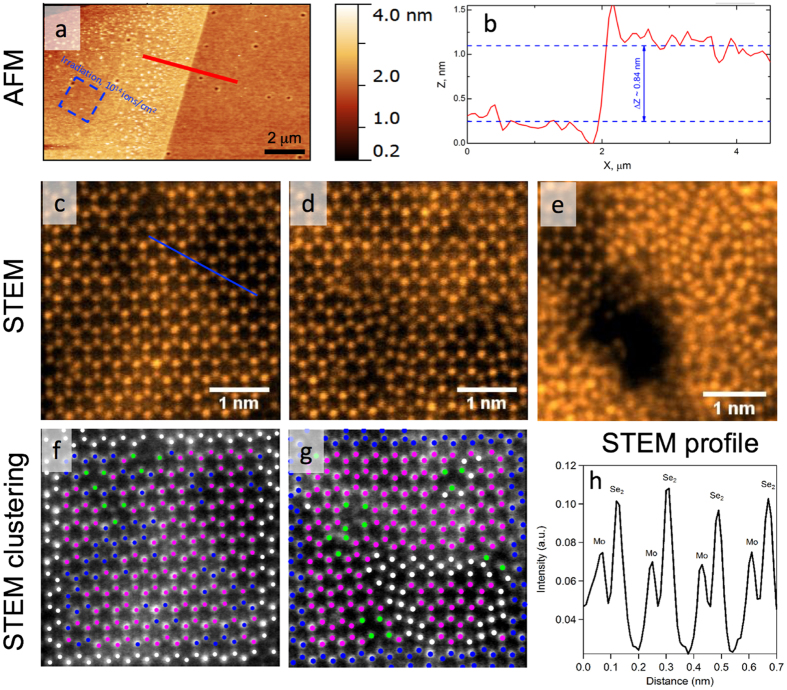
(a) AFM topography image of single layer supported MoSe2 flake and (b) its height profile as labeled on (a). (c–e) Atomic resolution MAADF-STEM images of (c) pristine region, (d) irradiated region at 1 × 1015 He+/cm2, and (e) 1 × 1016 He+/cm2. (f,g) k-means clustering STEM images in (c,d) color corresponds to the number of cluster. (h) Profile of pristine MoSe2 (c).